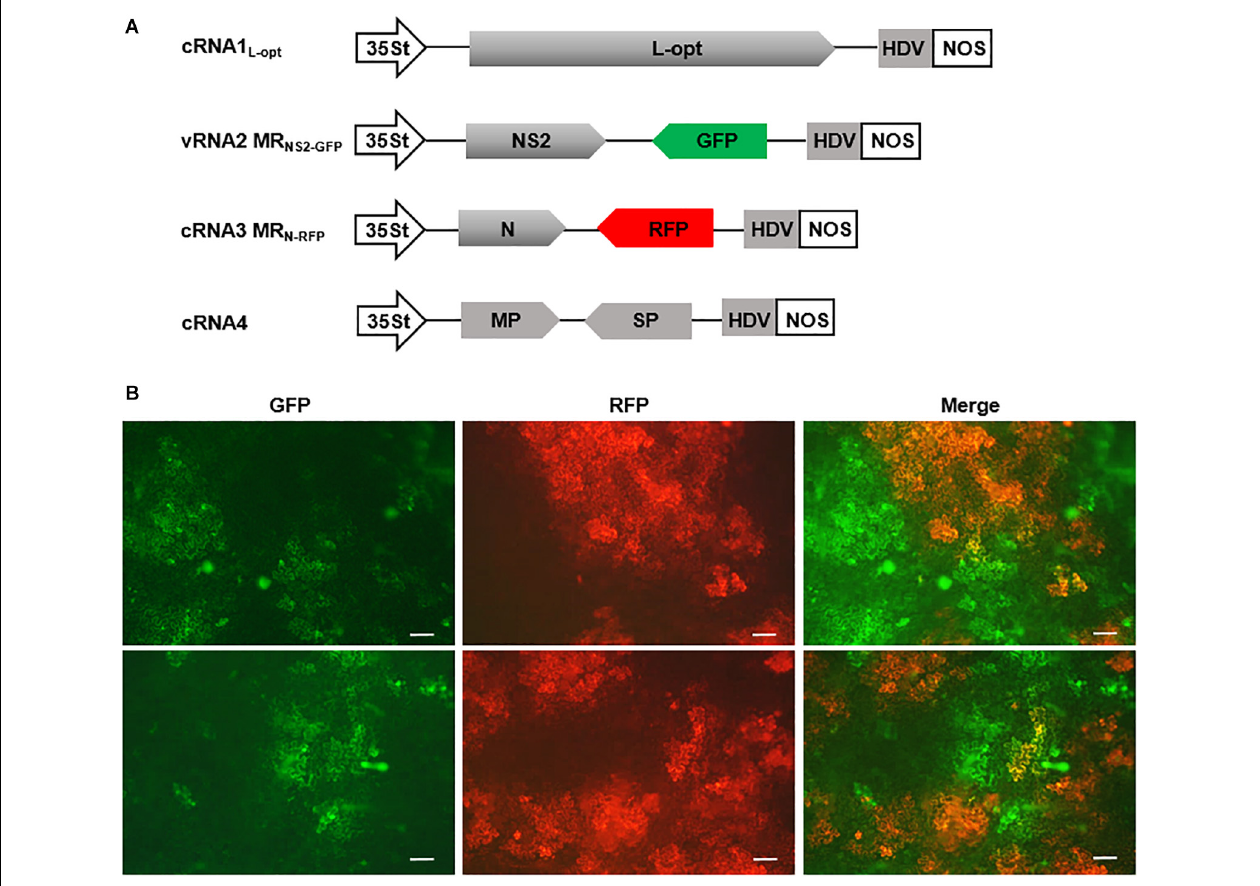
FIGURE 7 | A four-component system capable of autonomous replication and intercellular movement. (A) Diagrams showing the constructs designed for transcription of cRNA1 L − opt , vRNA2 MR NS2 − GFP , cRNA3 MG N − RFP , and cRNA4. vRNA2 MR NS2 − GFP contains a green fluorescent protein (GFP) reporter gene substitution for the GP gene, whereas cRNA3 MG N − RFP carries a red fluorescent protein (RFP) gene in place of the NS3 gene. (B) Visualization of GFP and RFP expression in N. benthamiana leaves infiltrated with mixtures of agrobacterial suspensions harboring the binary constructs shown in (A) and the viral suppressor of RNAs (VSRs) plasmid. The top and bottom panels show fluorescence in two representative leaves. Scale bar = 200 µ